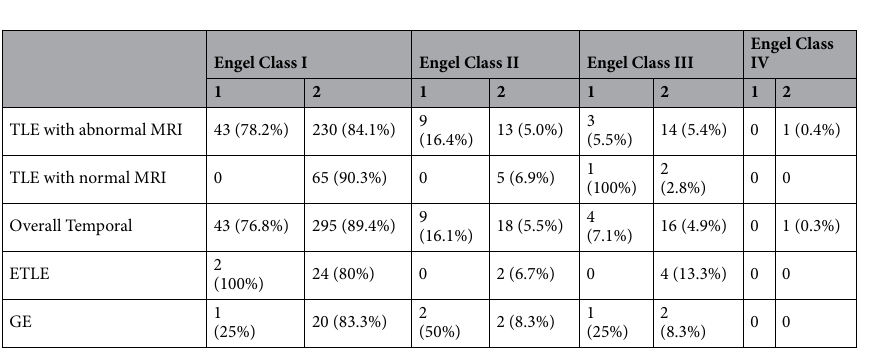
Figure 1. Engel class outcome distribution between the 1st and 2nd periods. Most of our patients achieved Engel Class I until the end of follow-up (December 2019).